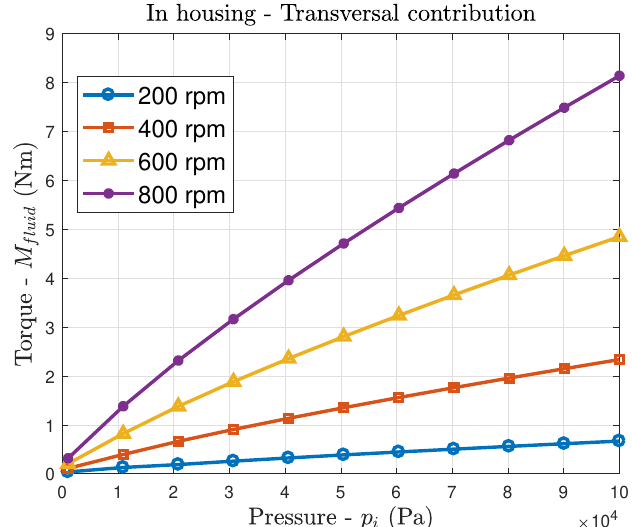
Figure 4. Transversal component on each disk of the fluid friction torque as a function of the pressure at different rotational